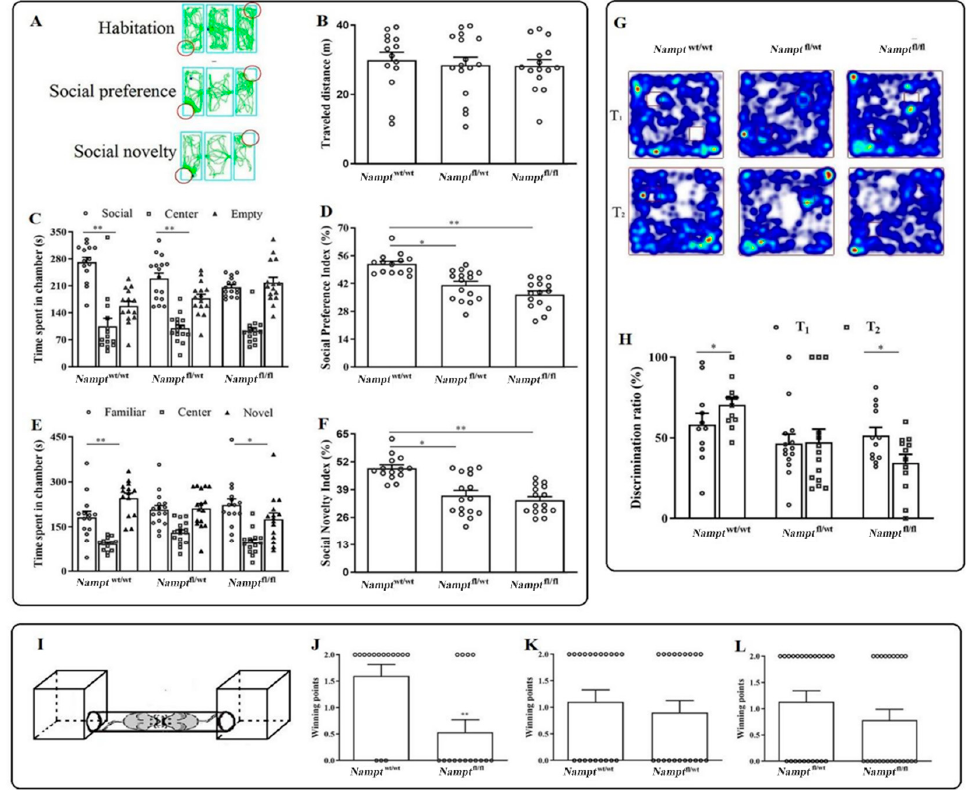
Figure 4. Behaviors in the SIT, NORT, and DTT in Nampt flox/flox mice. ( A ) Schematic diagram of the three-chambered test with an explanation of the three 10-min sessions. ( B ) Traveled distance during the habituation session. ( C ) Time spent during the sociability session in three chambers. ( D ) SPT during the sociability session. ( E ) Time spent during the sociability session in the three chambers. ( F ) SNI during the social novelty session. ( G ) Heatmap of NORT. ( H ) DR in NORT. ( I ) Schema of the DTT explaining the procedure of the test session. ( J ) Wining points in groups between Nampt wt/wt and Nampt flox/flox mice. ( K ) Wining points in groups between Nampt wt/wt and Nampt flox/wt mice. ( L ) Wining points in groups between Nampt flox/wt and Nampt flox/flox mice. ** p < 0.01 vs. social chamber in Figure 4C, vs. familiar chamber in Figure 4E, with * p < 0.05, ** p < 0.01 vs. Nampt wt/wt mice in Figure 4D, Figure 3F. ** p < 0.01 vs. Nampt wt/wt mice in Figure 4J and ** p < 0.01 vs. T 1